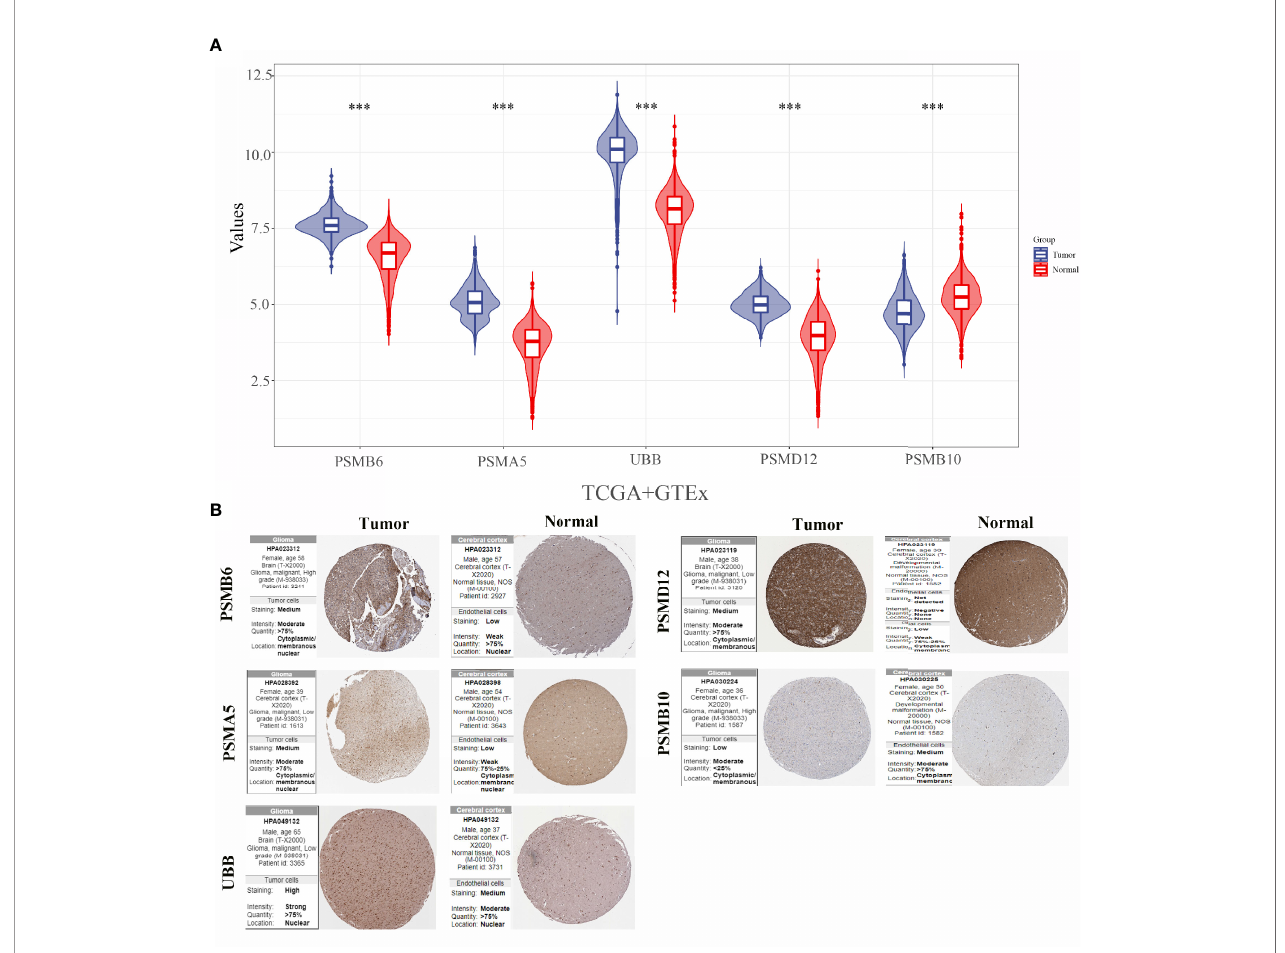
FIGURE 7 | Expressions and protein validations of PSMB10, PSMD12, UBB, PSMA5, and PSMB6 in gliomas. (A) Expression levels of fi ve genes in glioma samples from the TCGA and GTEx databases and (B) protein expression levels of fi ve genes in glioma tissues and normal brain tissues from the HPA database. ***p <